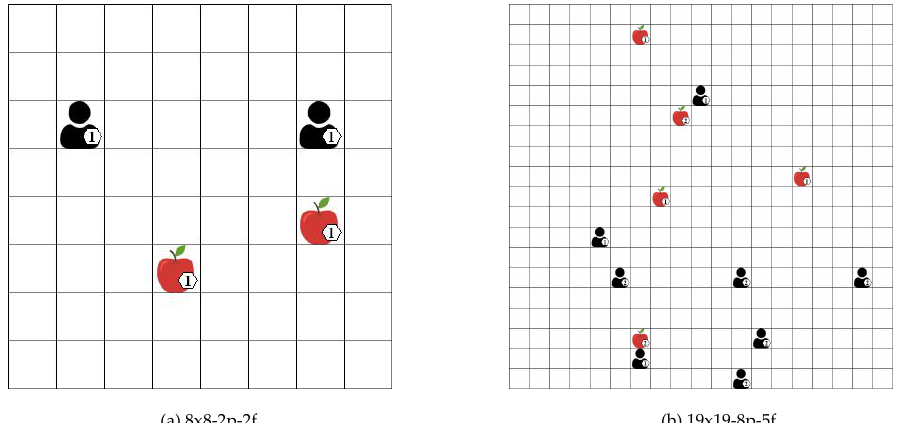
Figure 3. Illustration of LBF environment: ( a ) 8 × 8 grid, 2 players, 2 food items ( b ) 19 × 19 grid, 8 players, 5 food items.